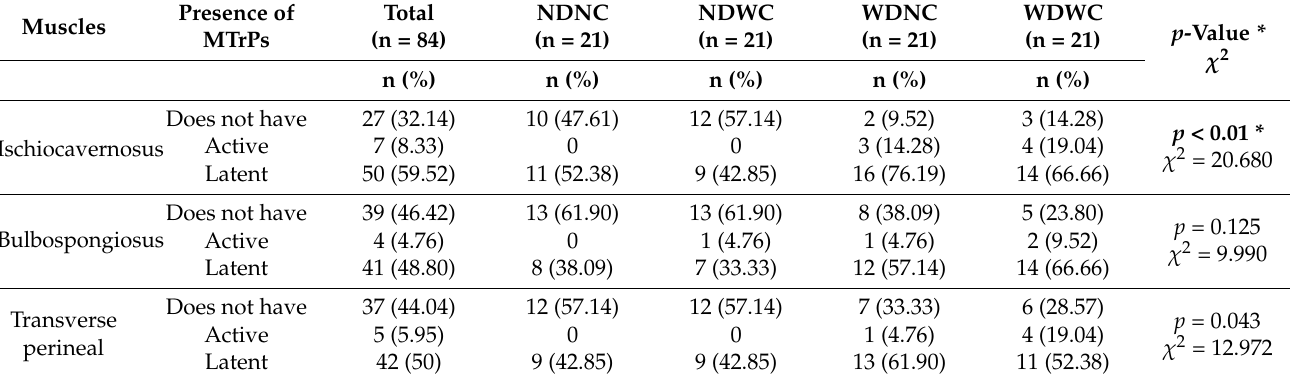
Table 6. Presence of MTrPs in the pelvic floor muscles evaluated in the menstrual